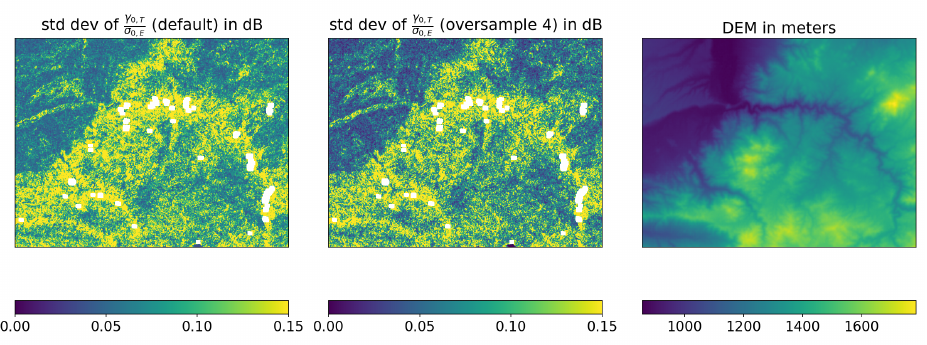
Figure 9. Standard deviation of the ratio of γ 0, T / σ 0, E with masked out regions in white for default oversampling factor ( Left ) and an oversampling multiple of 4 ( Middle ). Corresponding DEM over a rugged 15 km × 15 km area near Big Bear, California ( Right ). An oversampling multiple of 4 reduces the observed processing error but does not eliminate the correlation with